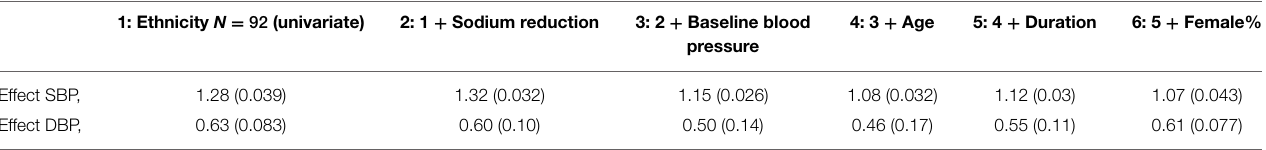
TABLE 3 | Regressionkoefficient, mmHg ( p -value) in univariate and multivariate regressionanalyses adjusted for additional confounders. 1: Ethnicity N = 92 (univariate) 2: 1 + Sodium reduction 3: 2 + Baseline blood 4: 3 + Age 5: 4 + Duration 6: 5 + pressure